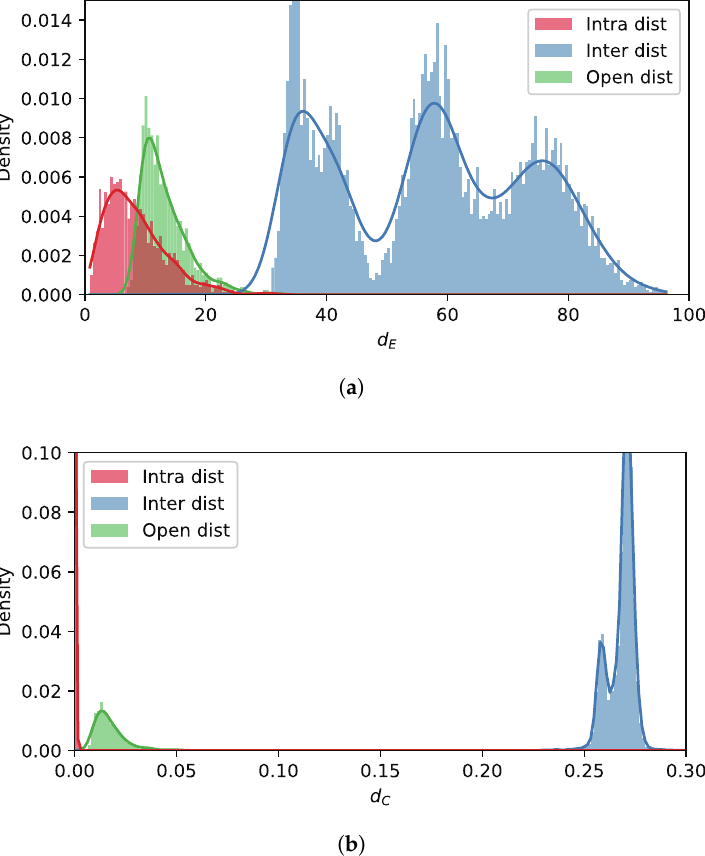
Figure 7. The comparison of the distance distribution of the features. ”Intra dist” indicates the distance distribution of the features from the same device with respect to the reference device, “Inter dist” indicates the distance distribution of the features from other authorized devices, and “Open dist” indicates the distance distribution of the features from the unknown device. ( a ) Softmax; ( b ) AAMSoftmax.